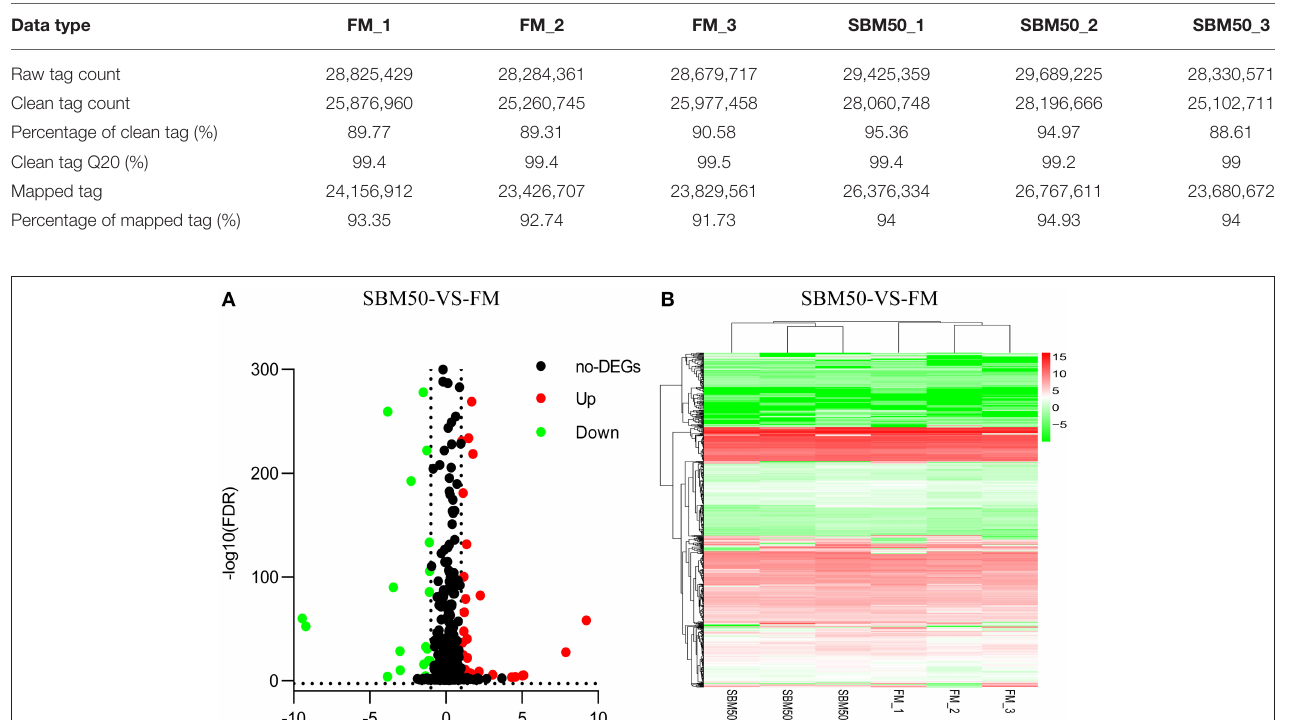
TABLE 4 | Overview of small RNA sequencing datasets.